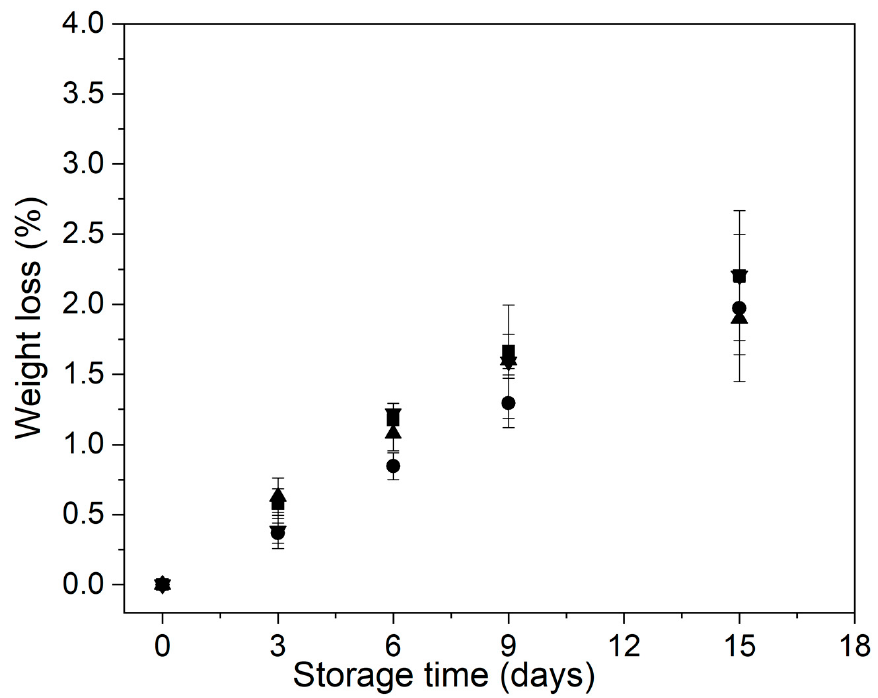
Figure 2. Behavior of the weight loss of control and treated minimally processed bunching green onion during storage. Control ( ■ ); mild-heat treatment ( ● ); edible coating ( ▲ ); mild-heat treatment+ edible coating ( ▼ ).